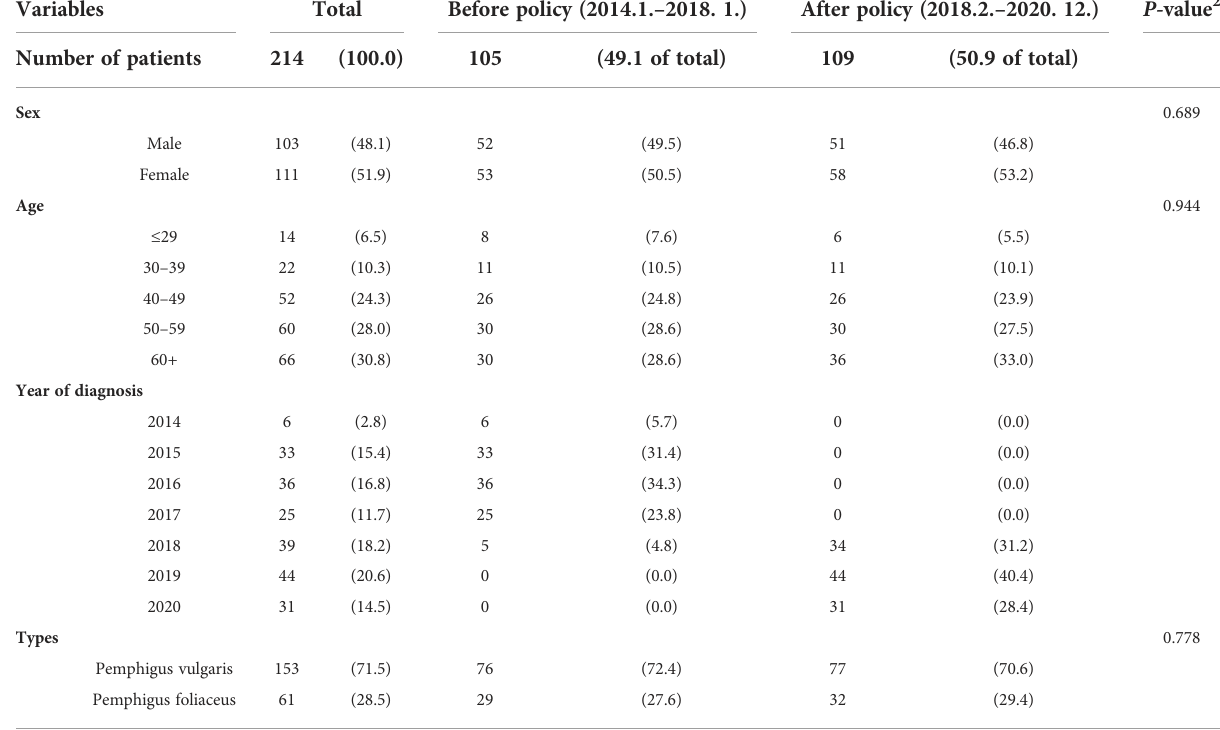
TABLE 1 General characteristics of the study population according to the timepoint of diagnosis of pemphigus 1 .